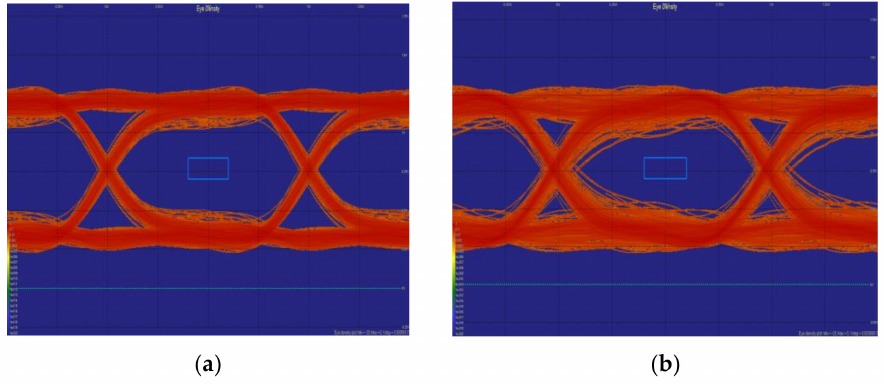
Figure 8. ( a ) 3.2 Gbps data rate channel with no defect ( b ) data channel with crack in solder ball. Table 2 shows data eye width, top margin and low margin values calculated for data rates 2.133 Gbps, 2.666 Gbps, and 3.2 Gbps. The percentage loss in data eye width